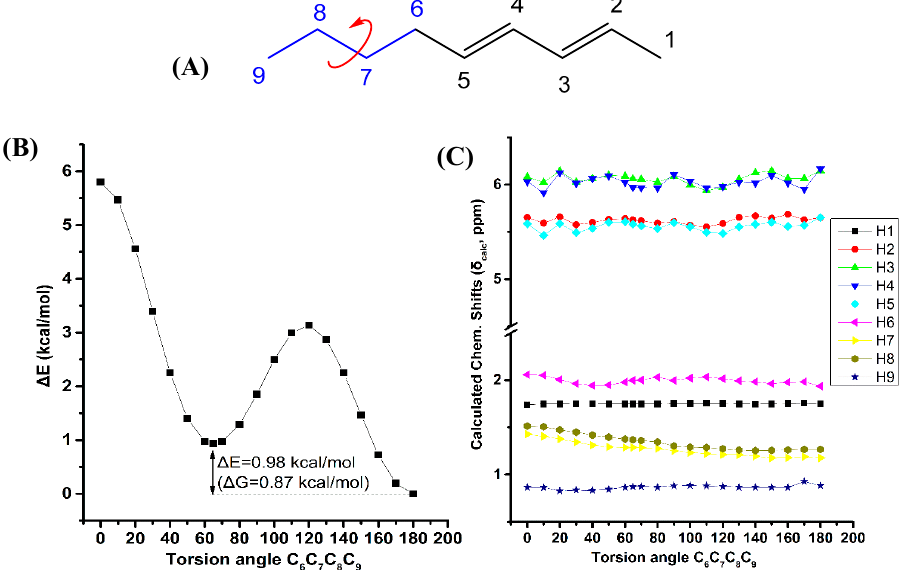
Figure 7. EffectofvariationoftheC 6 C 7 C 8 C 9 torsionangleof (E , E) -2,4-nonediene( A )ontheelectronicenergy ∆ E(kcal · mol − 1 ) ( B ), and the 1 H-NMR chemical shifts ( C ) with energy minimization at the B3LYP / 6-31 + G(d) level. The Gibbs energy difference, ∆ G, of the two low energy conformers is also